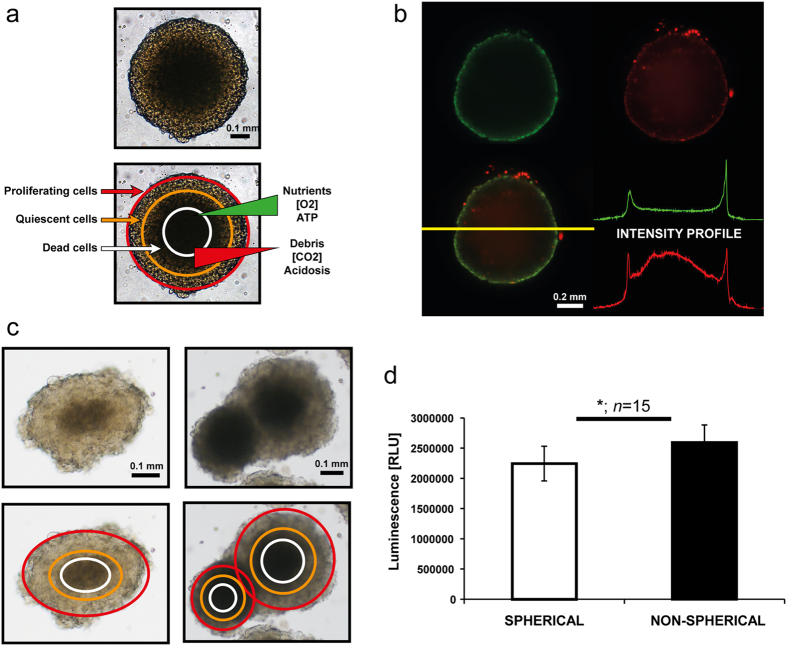
Relation between shape and viability of cells composing the spheroids.(a) Brightfield image of A549 spherical colony (top figure) and the same image with pathophysiological gradients schematically reported (bottom figure). Scale bar = 0.1mm. (b) Optical section of a live, spherical tumor spheroid obtained with light sheet fluorescence microscopy (LSFM, Lightsheet Z.1, Zeiss). Green = calcein-positive (live) cells; red = ethidium-positive (dead) cells. Scale bar = 0.2 mm. The fluorescence intensity profiles for both channels show the different distribution of live and dead cells in the spheroid structure; plots normalized on respective maximum value. (c) Variations in tumor shape are also accompanied by changes in the dimension of the inner core and in the thickness of the external layers mainly composed of actively proliferating cells. Brightfield images; scale bar = 0.1 mm. (d) Cell viability of tumor spheroids with homogeneous volume but different shapes (spherical vs. non-spherical) measured by CellTiter-Glo®3D Cell Viability assay. Bars = standard deviation (SD); means were calculated from a group of 15 spheroids/data set (n). *P = 0.045.